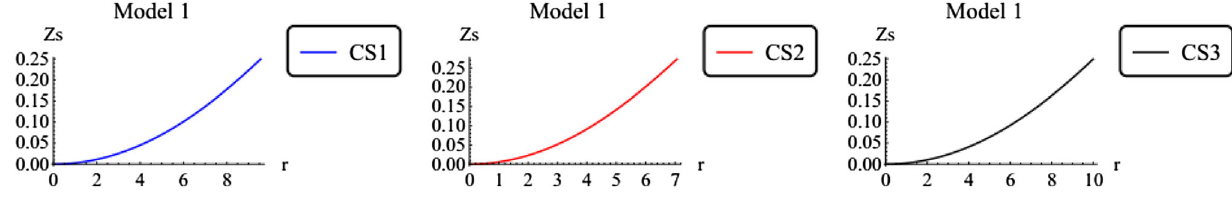
Fig. 17 Variations of the Redshift for different charged compact stars